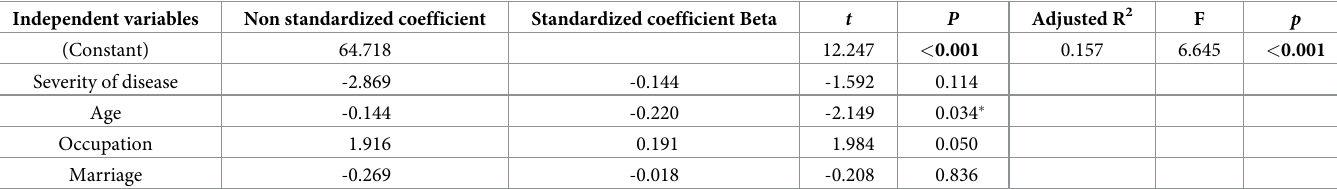
Table 4. Multiple linear regression analysis of stigma in COVID-19